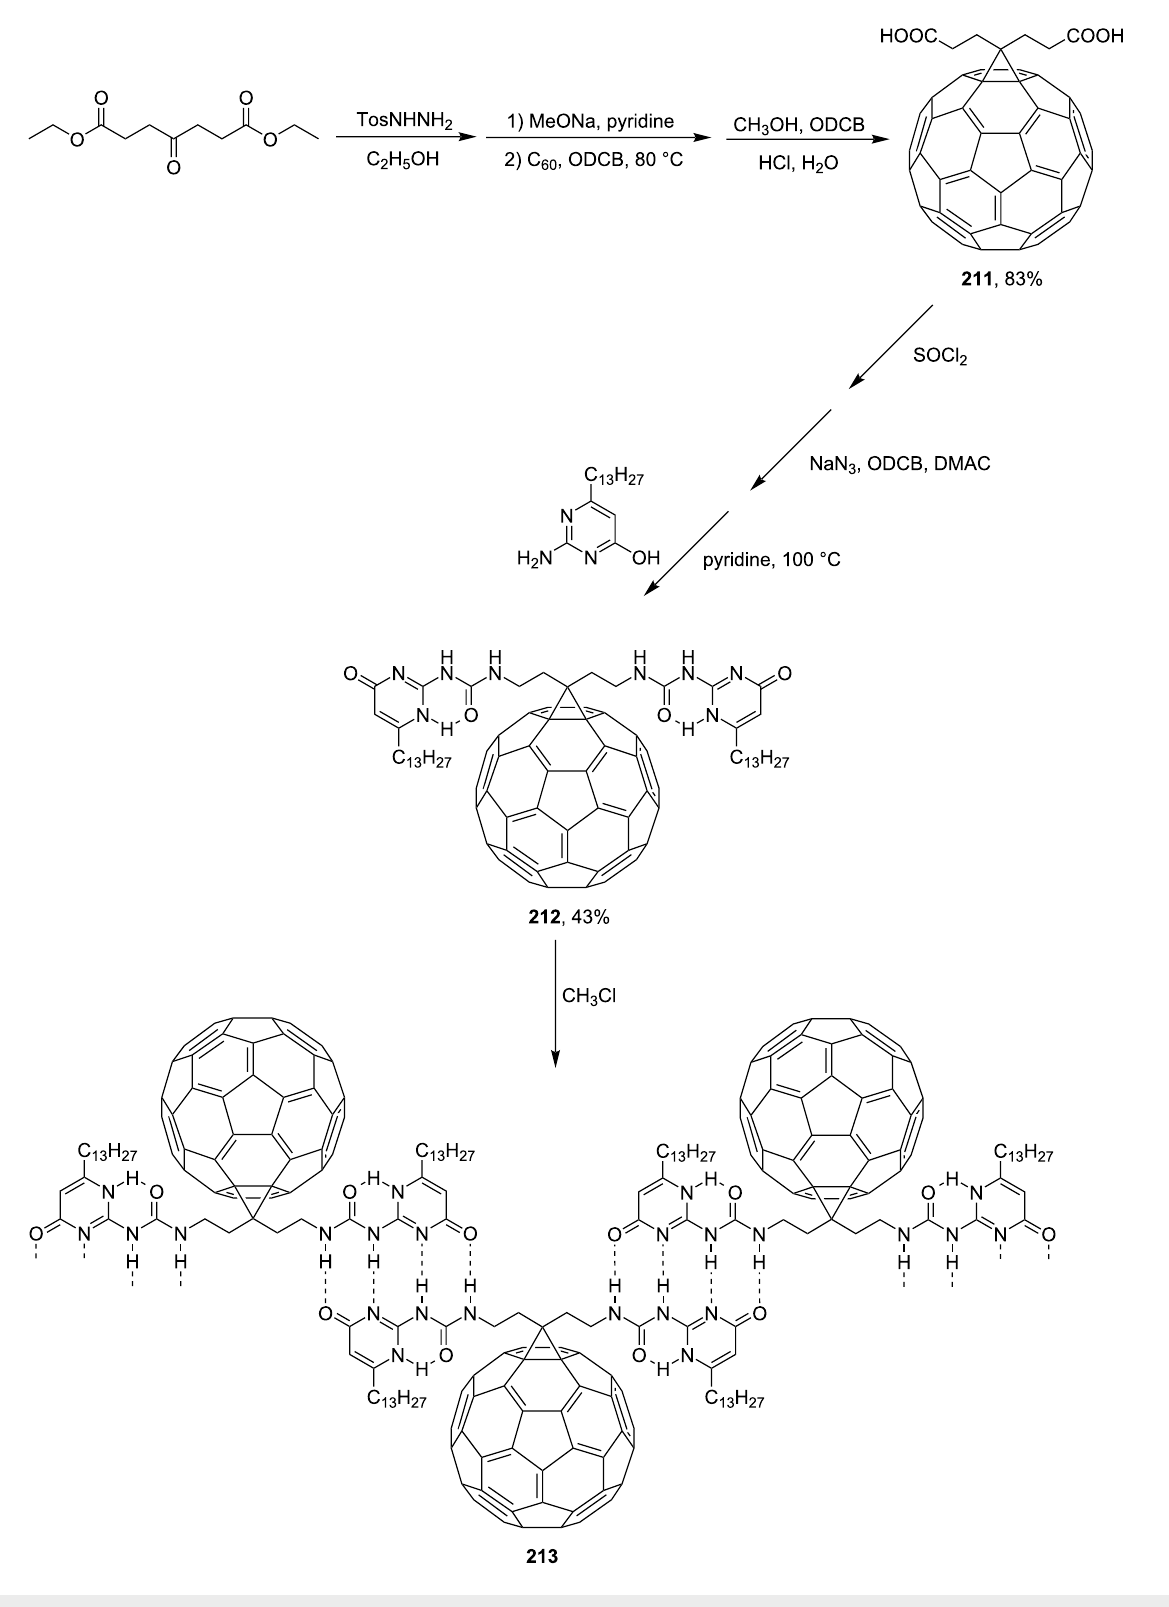
Scheme 44: The synthetic route to quadruple hydrogen ‐ bonded fullerene array 213